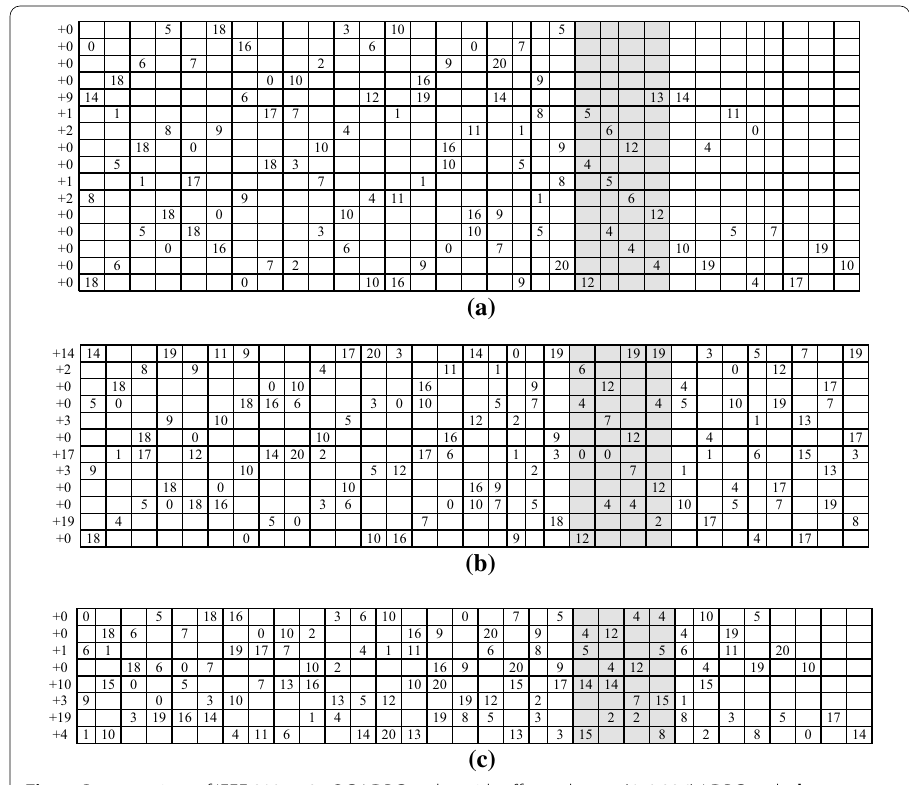
Fig. 4 Base matrices of IEEE 802.15.3c QC-LDPC codes with offset values: a (672,336)-LDPC code; b (672-425)-LDPC code; c (672,504)-LDPC